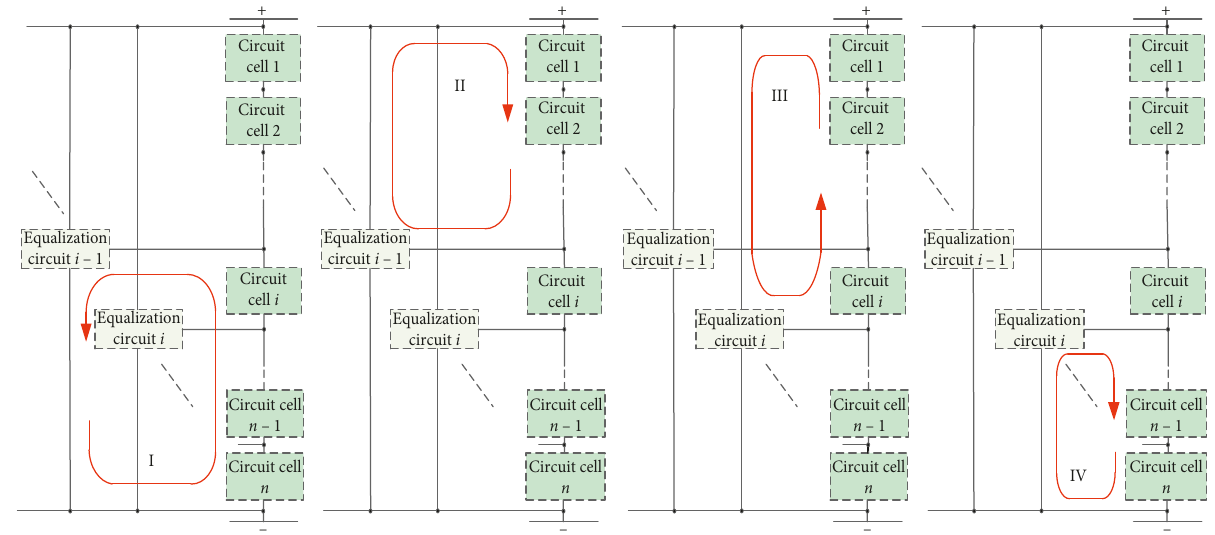
Figure 3: Energy transfer path schematic. (a) Mode I, (b) mode II, (c) mode III, and (d) mode IV.